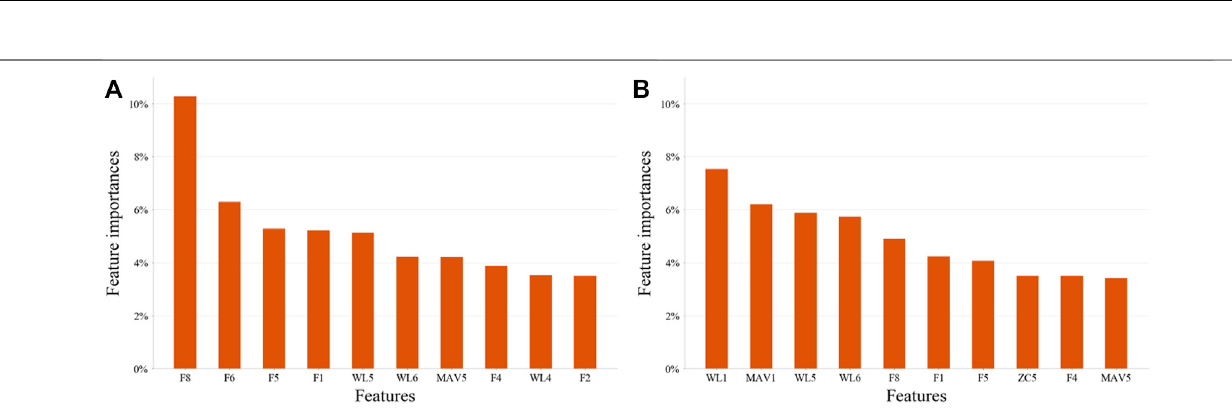
Frontiers in Physiology |